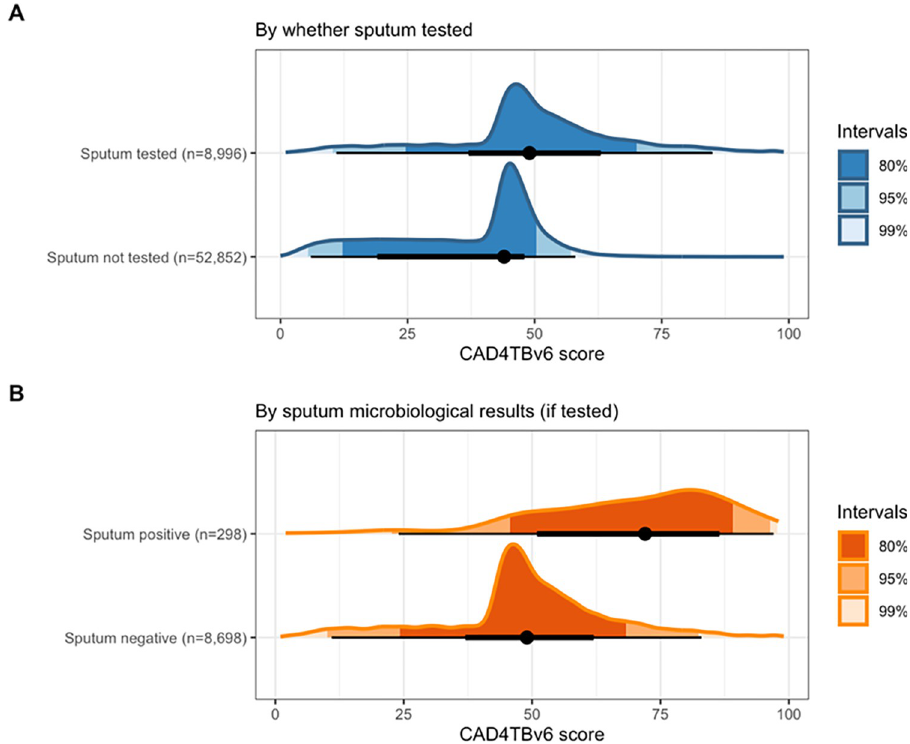
Fig 2. Distribution of CAD4TBv6 scores in Kenya National TB prevalence survey. A) Distribution (median and 95% highest density interval) of CAD4TBv6 scores by whether prevalence survey participant’s sputum was tested or not. B) Distribution (median and 95% highest density interval) of CAD4TBv6 scores by sputum bacteriological results. 95%HDI: 95% highest density